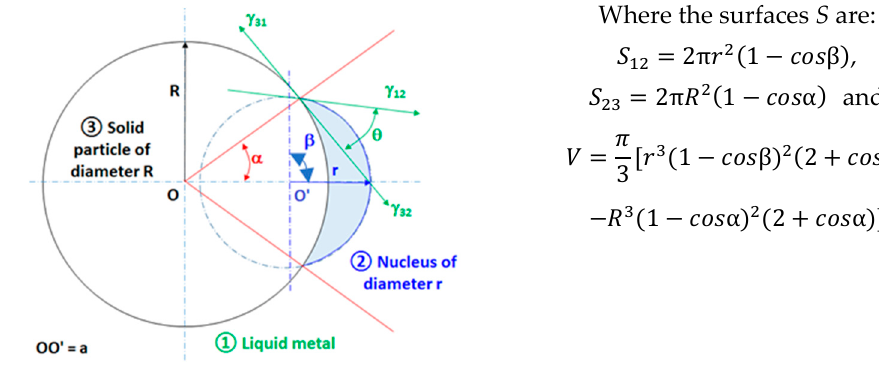
Figure 1 . Schematic illustration of the spherical particle nucleation.